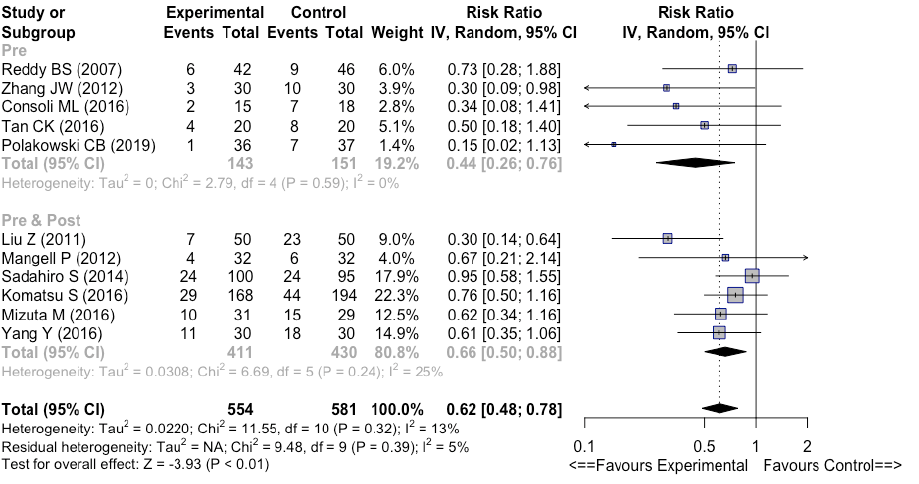
Figure 6. Forest plot of the timing of perioperative [26,27,31,34,35,37] versus preoperative [24,28,33,36,40] use of probiotics or synbiotics. Outcome = overall infectious complications.